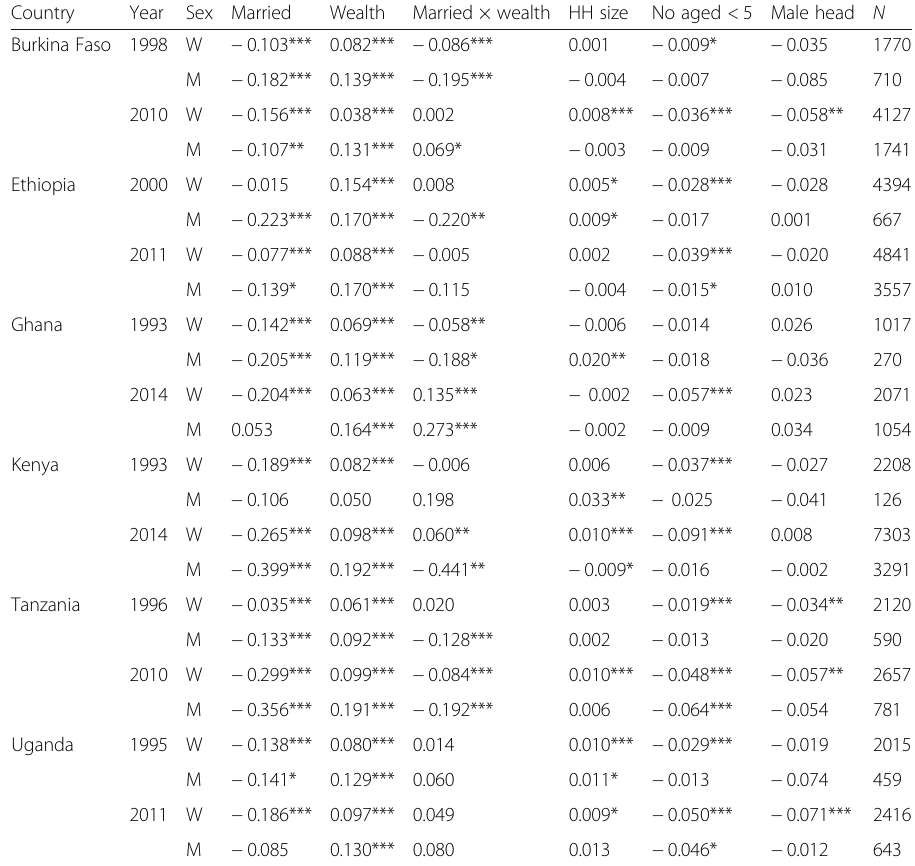
Table 11 Selected LPM regression coefficients: dependent variable: has some secondary education